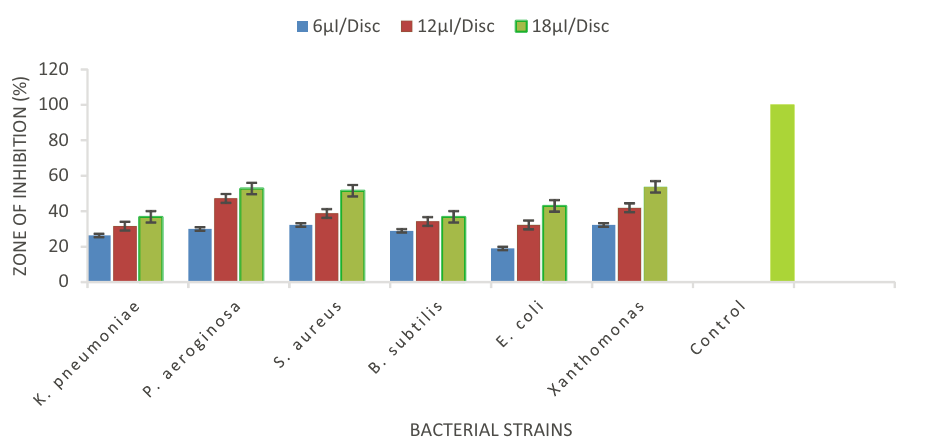
Figure 14: Antibacterial activity with a standard deviation of AgNPs of crude methanolic extract of T. govanianum against di ff erent bacterial strains by disc di ff usion assay.